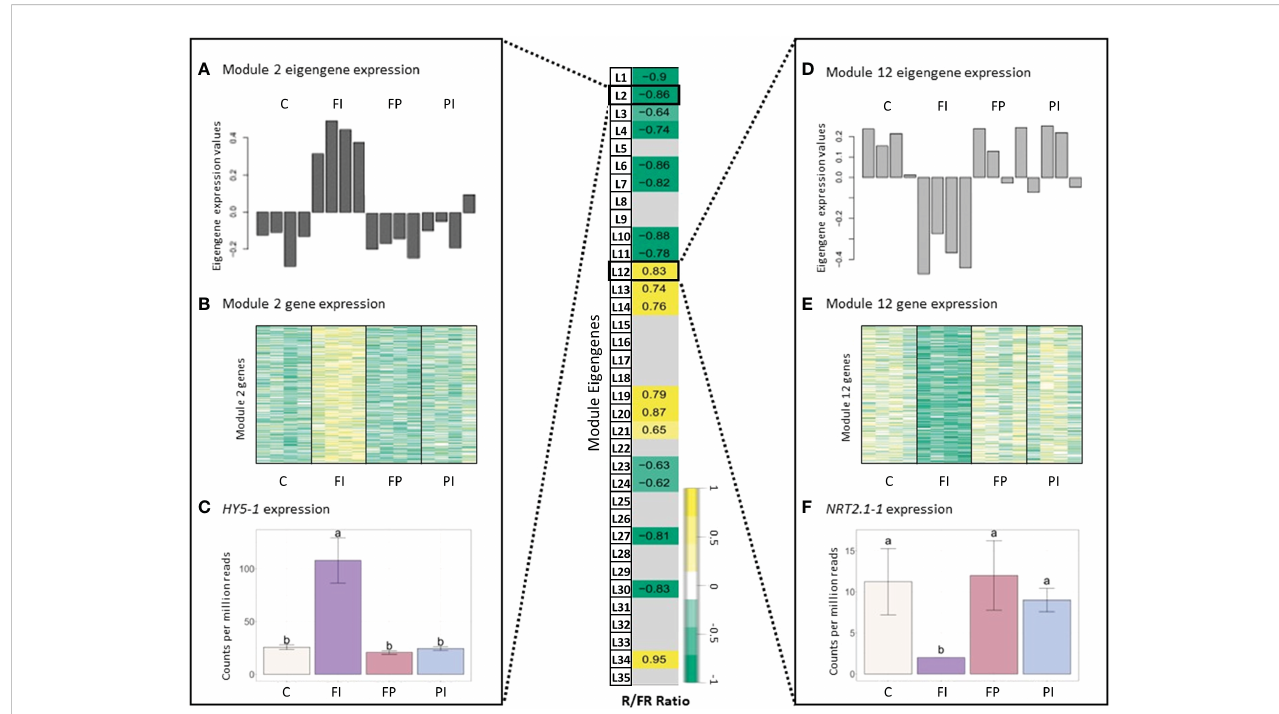
FIGURE 6 Gene expression in lettuce correlated with R/FR ratio. Module-trait relationships and differential gene expression between lettuce fi lter treatments and control. (A) Normalized expression of the Lettuce Module 2 eigengene expression for each of the treatments by sample. Table values given are the correlation coef fi cient ( r ) for each relationship. Insigni fi cant correlations were removed (p<1e-05). Error bars indicate the standard deviation. Letters indicate signi fi cance from ANOVA and Tukey test (p<0.05). See Figure S13 for full table. (B) Heatmap of gene expression for all genes in Lettuce Module 2, where dark yellow indicates a strong increase in expression and dark green indicates a strong decrease in expression. (C) Normalized gene expression of a Lettuce Module 2 hub gene, elongated hypocotyl 5 ( HY5-1 ). (D – F) Eigengene expression, gene expression and hub gene expression ( high-af fi nity nitrate transporter 2.1 , NRT2.1-1 ) for Lettuce Module 12. The treatment with the lowest R/FR ratio, FI, had higher gene expression in Lettuce Module 2, resulting in a negative correlation with the R/FR ratio. In contrast, Lettuce Module 12 had a positive correlation with R/FR ratio due to the downregulation of expression in FI, relative to the other